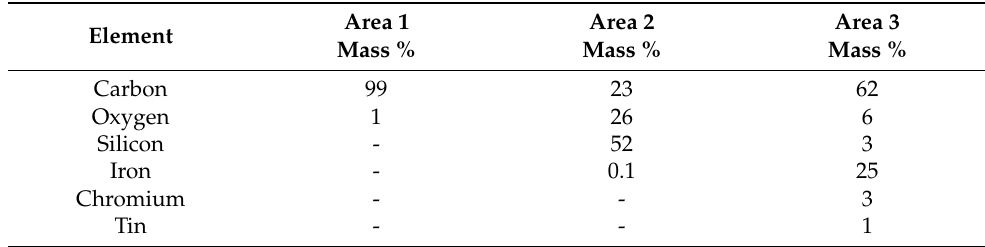
Table 7. EDXS analysis of the particles that are shown in Figure 13 at the regions that are marked by ‘1, 2, and